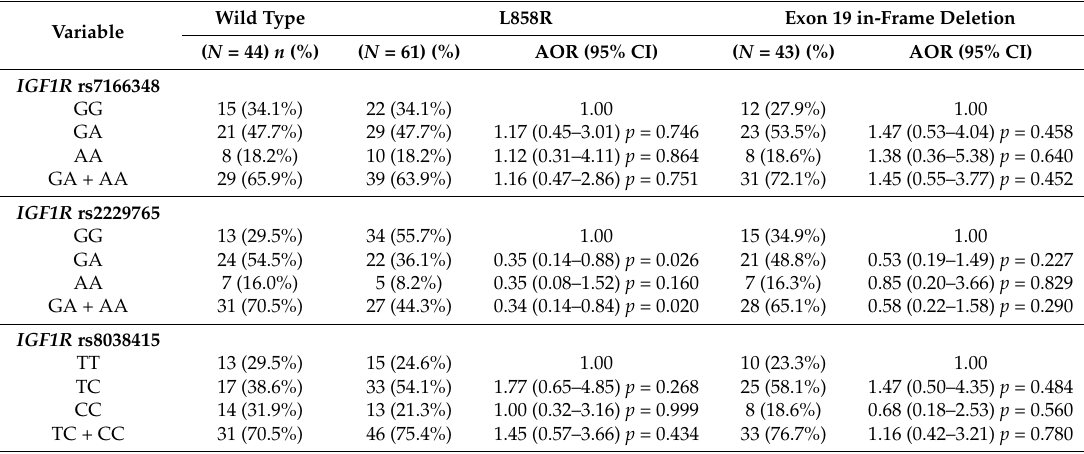
Table 5. The associations between the polymorphisms of IGF1R and the EGFR hotspot mutations in female lung adenocarcinoma